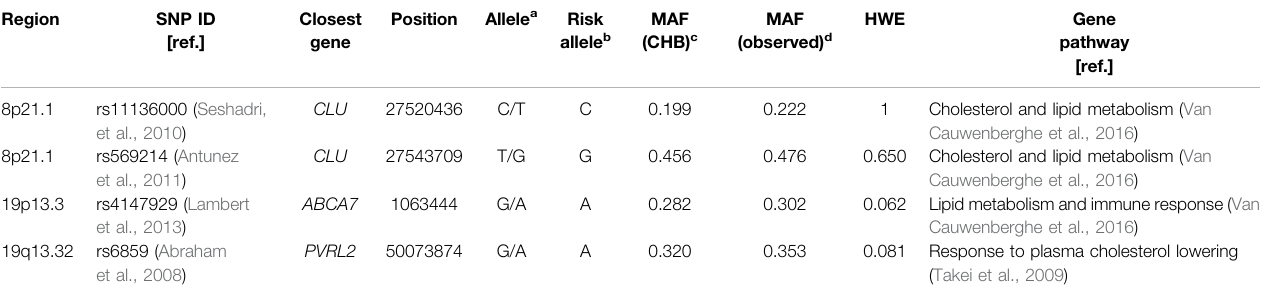
TABLE 1 | Selected AD GWAS-SNPs in cholesterol/lipid metabolism – related genes evaluated in this study. Region SNP ID